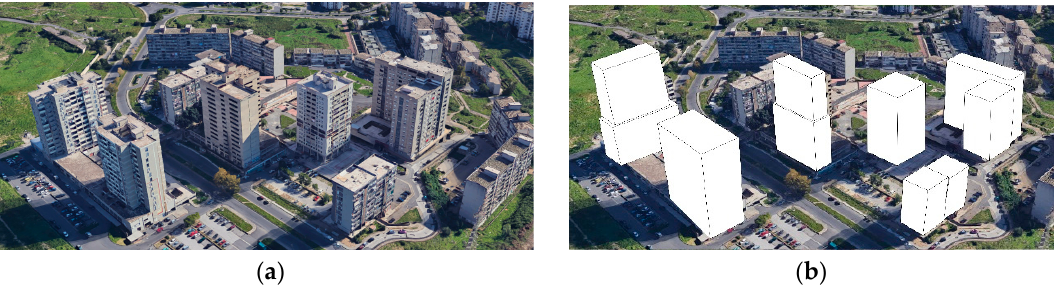
Figure 1. Aerial view of ( a ) residential blocks and ( b ) their beam-like idealization.